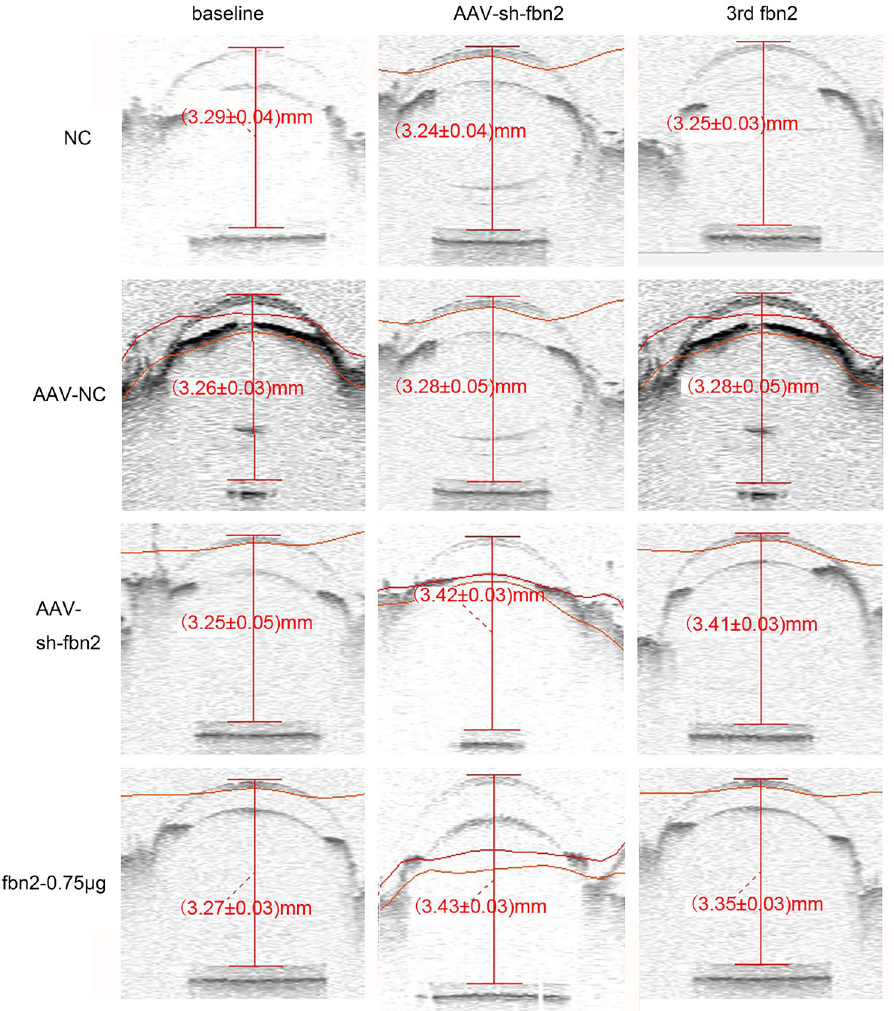
Figure 5. Axial length measured by OCT. NC group: Animals without intervention. AAV-NC group: Animals with an intravitreal injection of AAV empty vector and without any further treatment. AAV-sh-fbn2 group: Animals with an intravitreal injection of AAV-sh-fbn2 and without any further treatment. Fbn2-0.30 μg group: Animals with an intravitreal injection of AAV-sh-fbn2, followed by an intravitreal injection of fbn2 recombinant protein in a dose of 0.30 μg. Fbn2-0.75 μg group: Animals with an intravitreal injection of AAV- sh-fbn2, followed by an intravitreal injection of fbn2 recombinant protein in a dose of 0.75 μg. Fbn2-1.5 μg group: Animals with an intravitreal injection of AAV-sh-fbn2, followed by an intravitreal injection of fbn2 recombinant protein in a dose of 1.50 μg. Fbn2-3.0 μg group: Animals with an intravitreal injection of AAV-sh- fbn2, followed by an intravitreal injection of fbn2 recombinant protein in a dose of 3.00 μg.